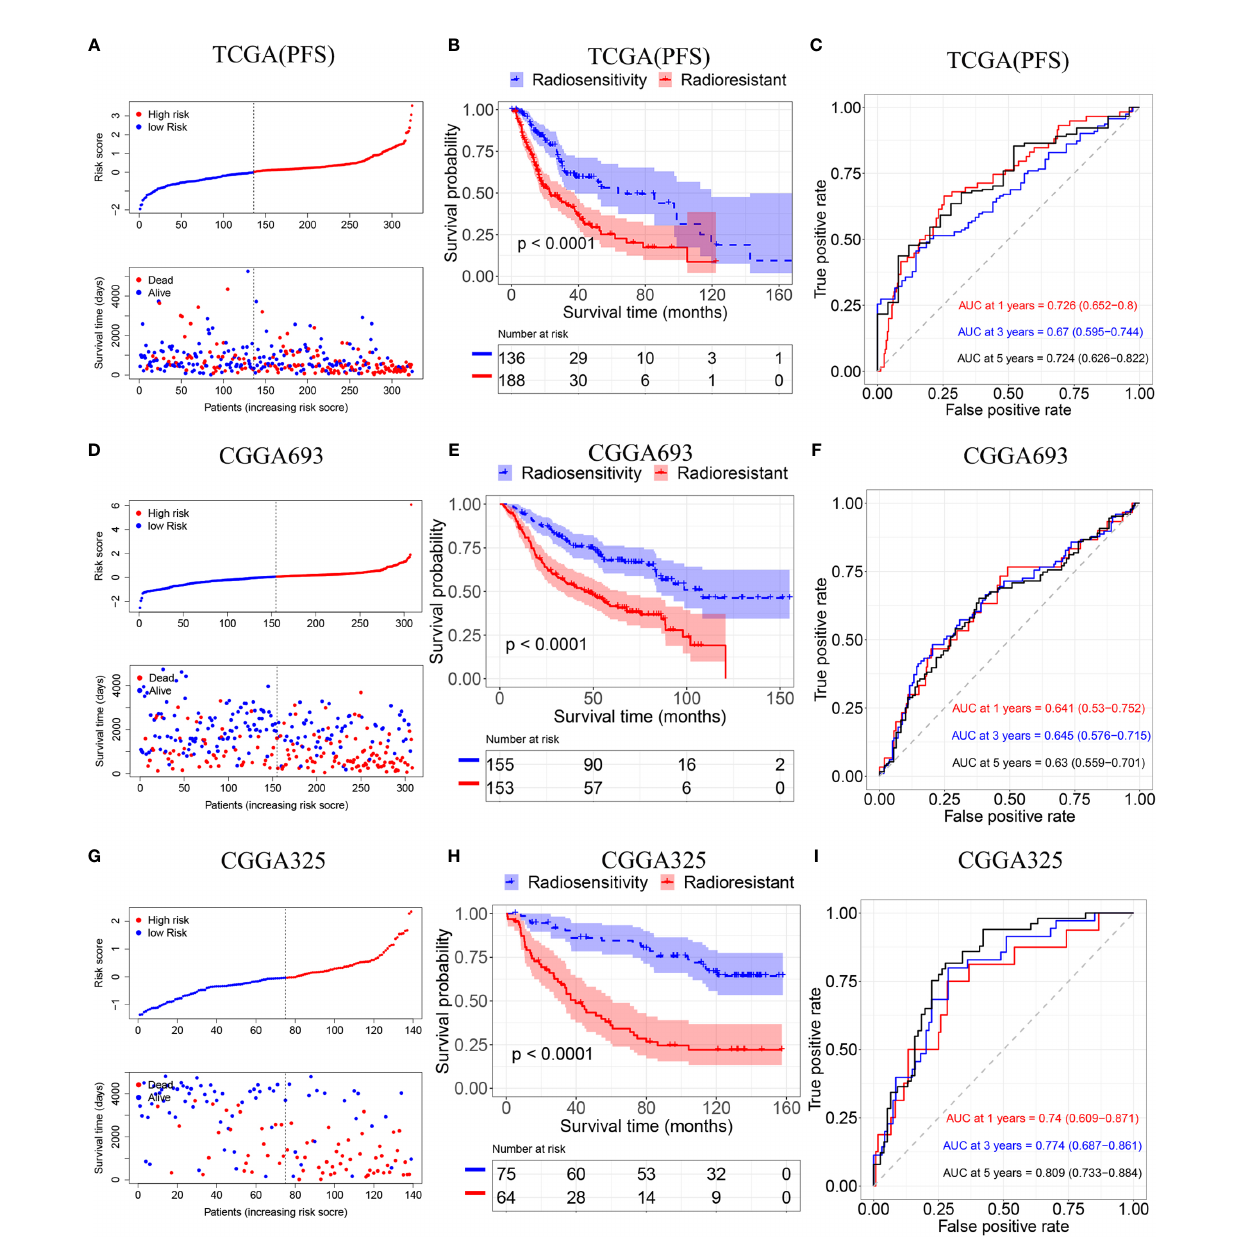
FIGURE 4 | Validation of the radiosensitivity-related risk score model. (A) Risk scores distribution of each patient in the TCGA(PFS). (B) Kaplan – Meier curves for the RS group and RR group in patients with radiotherapy from TCGA(PFS). (C) Time-dependent ROC curve analysis of the radiosensitivity-related risk score in the TCGA (PFS). (D) Risk scores distribution of each patient in the CGGA693. (E) Kaplan – Meier curves for the RS group and RR group in patients with radiotherapy from CGGA693. (F) Time-dependent ROC curve analysis of the radiosensitivity-related risk score in the CGGA693. (G) Risk scores distribution of each patient in the CGGA325. (H) Kaplan – Meier curves for the RS group and RR group in patients with radiotherapy from CGGA325. (I) Time-dependent ROC curve analysis of the radiosensitivity-related risk score in the